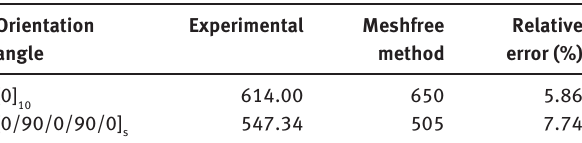
Table 3 Comparison of the critical loads for carbon/epoxy laminate (AS4/3501-6) in mode II.